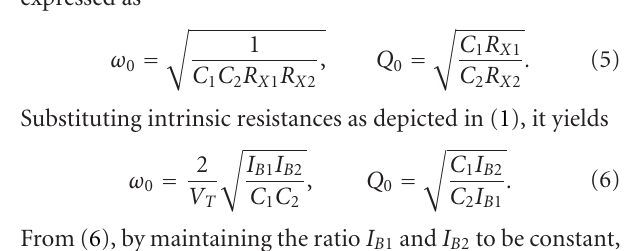
Table 3: Parameters of the transistors. .model PX